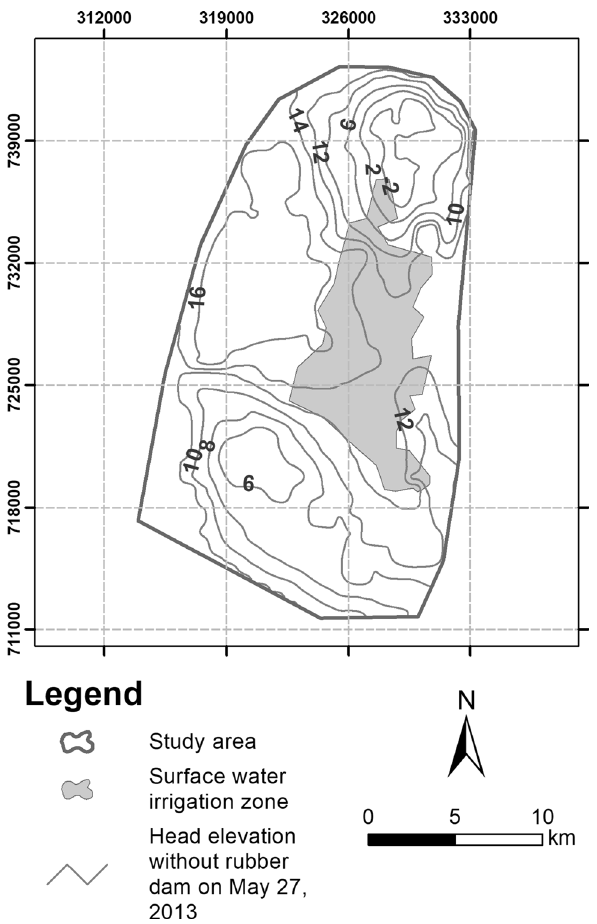
Fig. 10 GWL contour map of May 27, 2029, for scenario-1 showing the lowest GWL of -4 mPWD to the north of the model area where Nachole and Gomastapur Upazilas are located. The highest GWL (14 mPWD) is seen to the west of the model domain. The highest GWL is observed inside the surface water irrigation zone which is 12